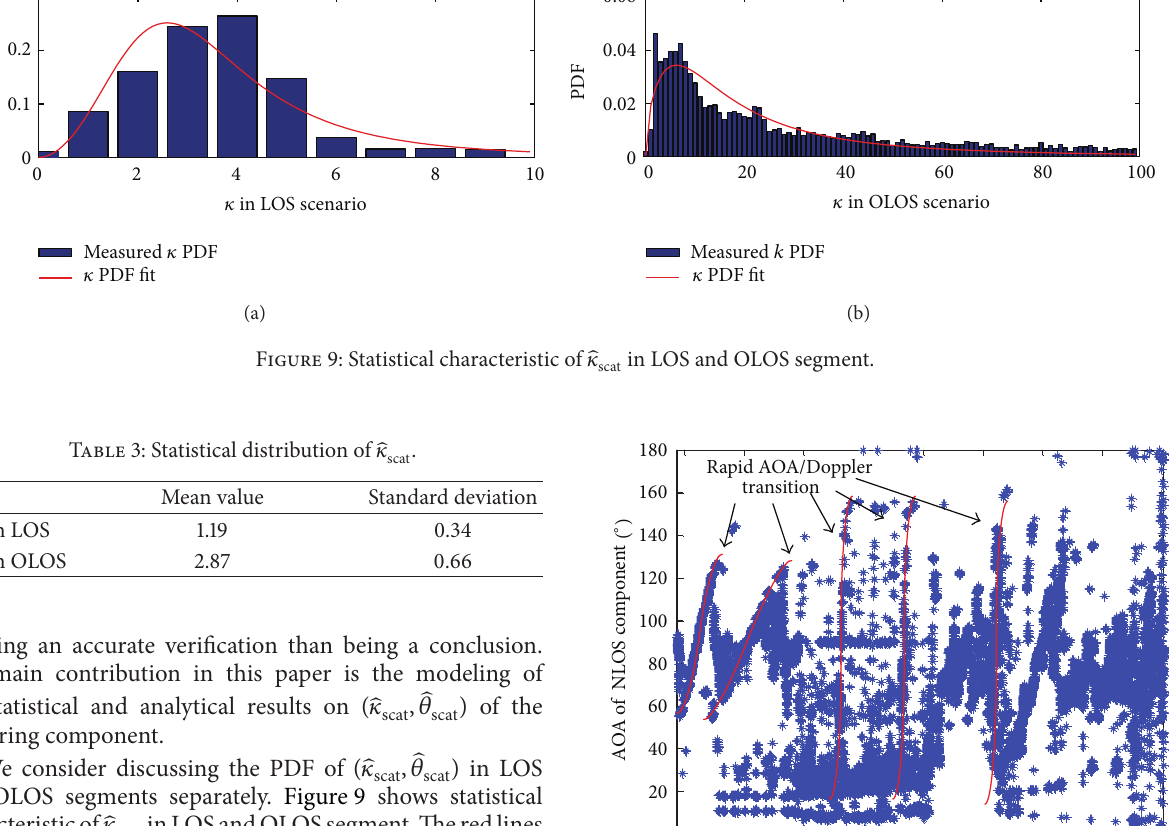
̂𝜃 versus distance. scat